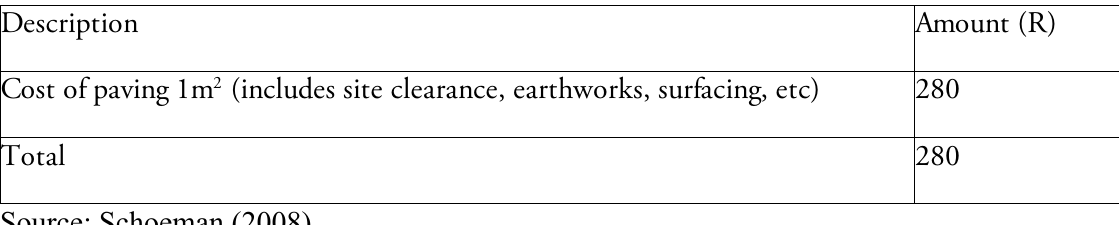
Table 5: Costs of covering unpaved areas and walkways